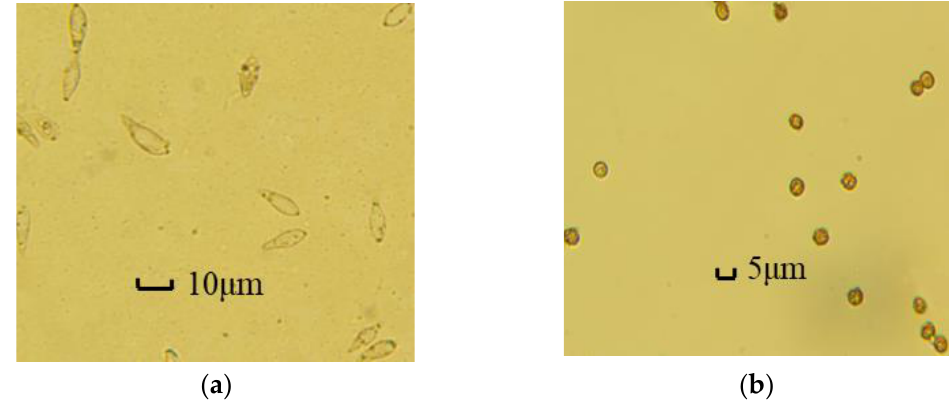
Figure 7. ( a ) Results of Magnaporthe grisea spores enrichment; ( b ) results of Ustilaginoidea virens spores enrichment.